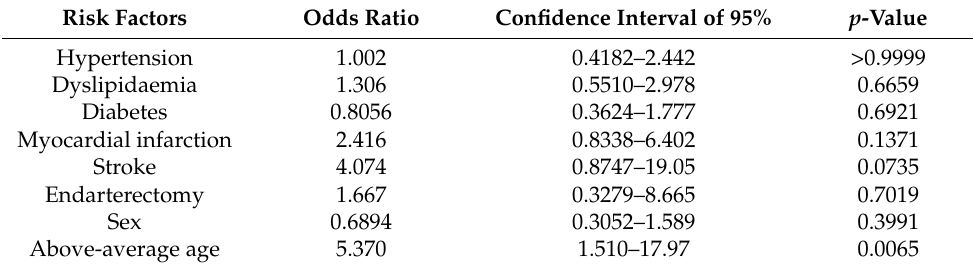
Table 9. Analysis of the correlations between the risk factors and worsening of stenosis in smokers (worsened patients: 65; stable patients: 42; and total patients: